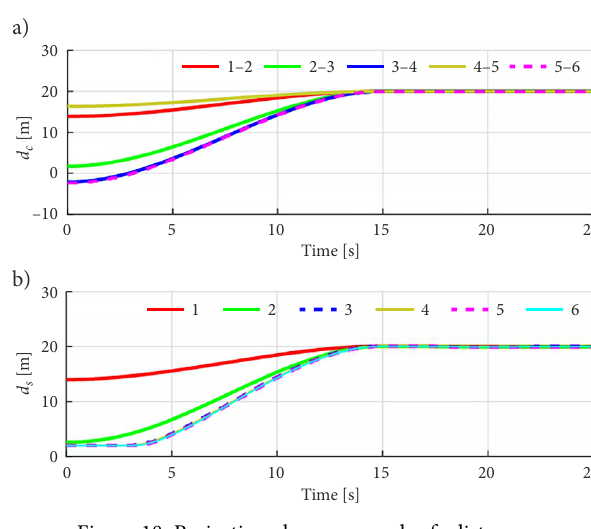
Figure 18. Projection clearances and safe distances (source: created by the